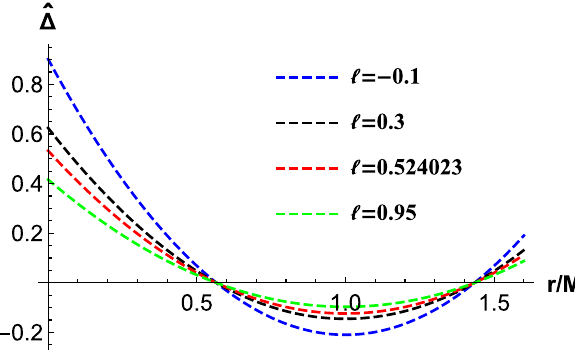
Fig. 2 It gives variation of ˆ (cid:5) for various values of (cid:2) with b = 0 . 01 M 2 and ˆ a = 0 . 6